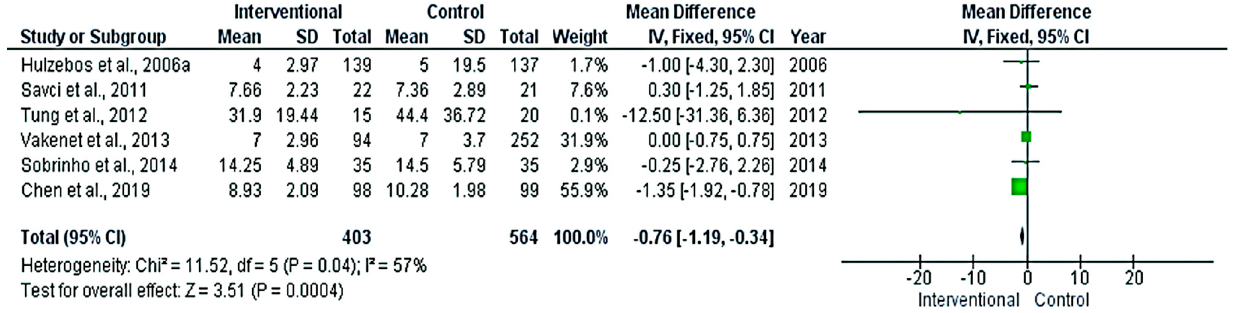
Figure 5. Forest plot evaluating hospital stay length in the included studies.